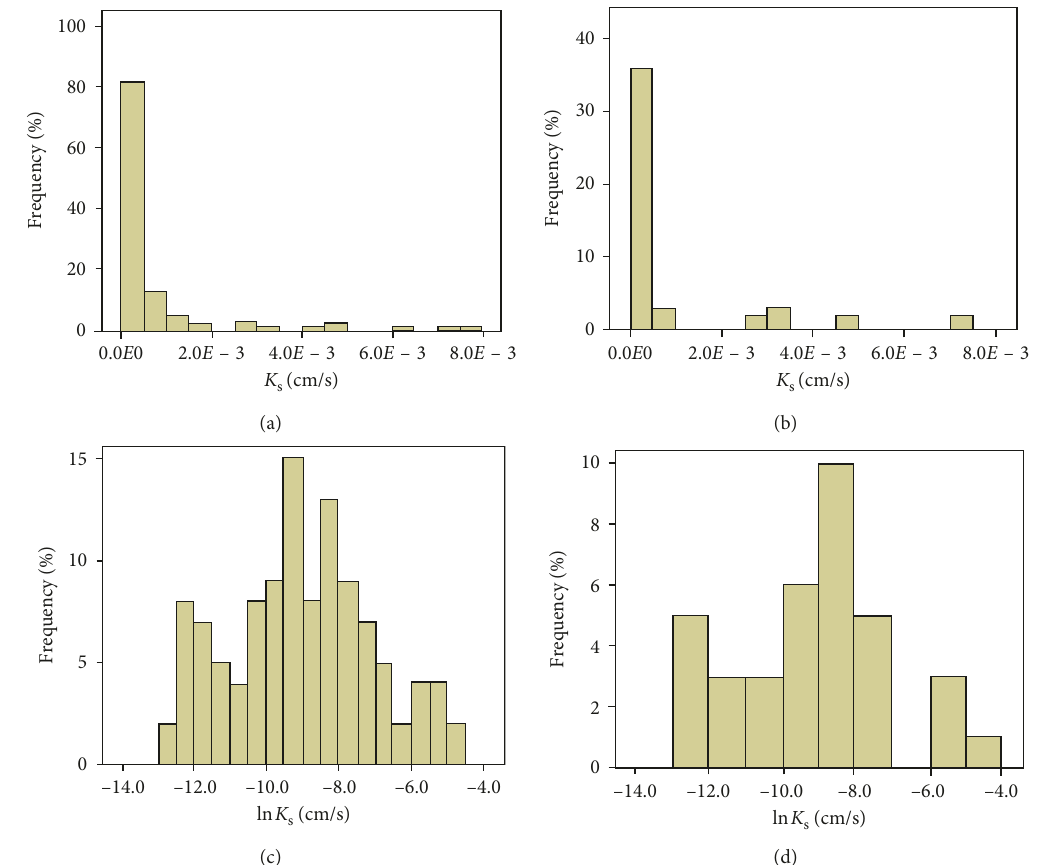
Figure 5: Histograms of the estimated K (d) ln K s for the major cross